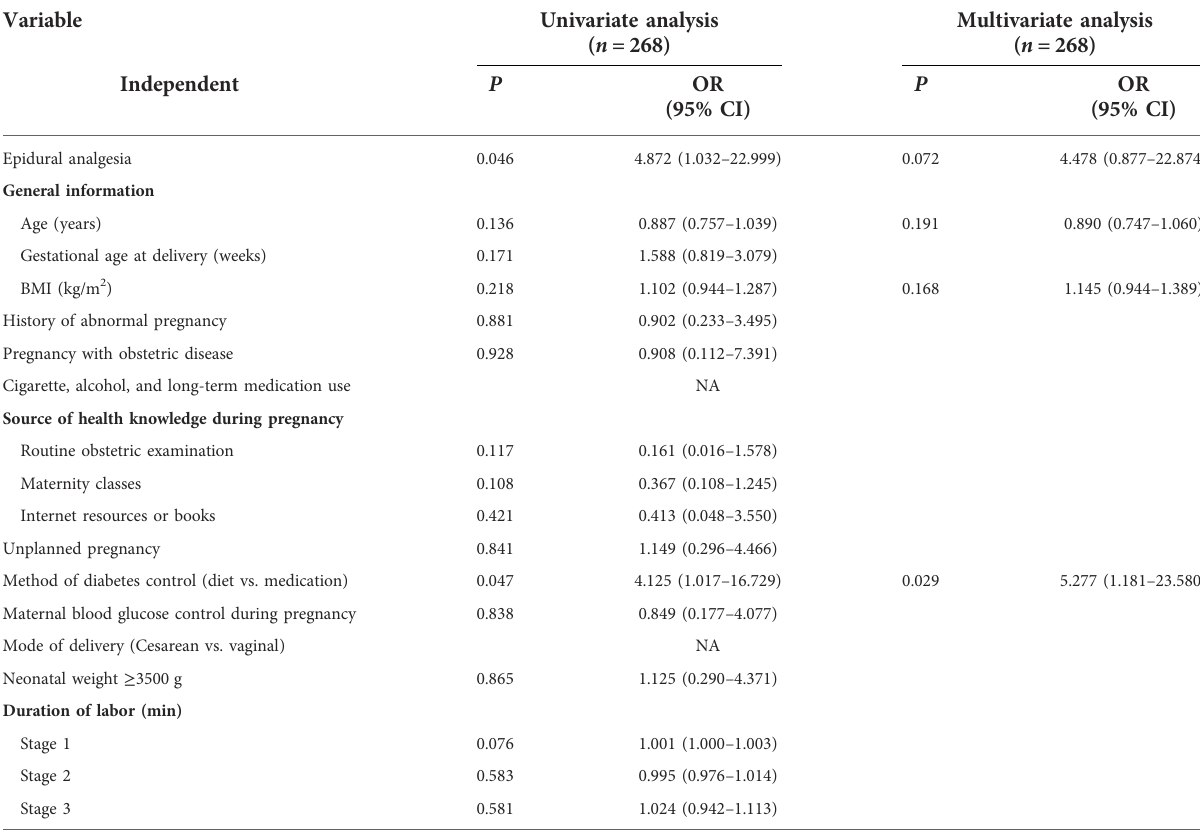
TABLE 4 Results of univariate and multivariate analyses of factors associated with the rate of neonate transfer to the NICU for hypoglycemia treatment.